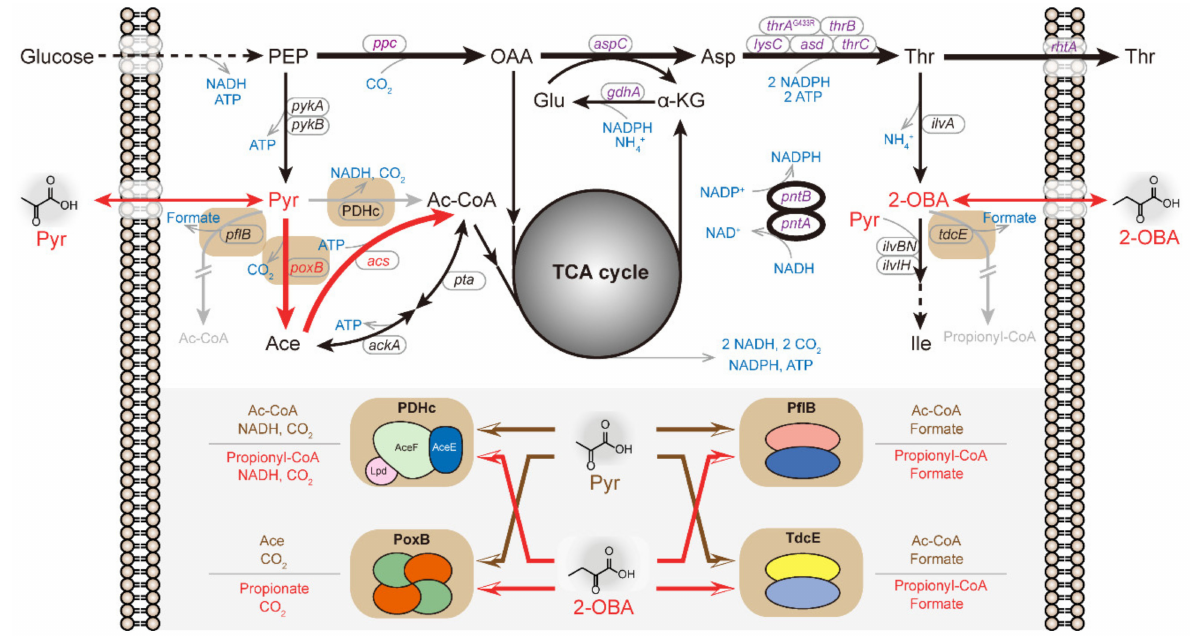
Figure 1. The competition of 2-OBA and Pyr in the L -threonine-overproducing E. coli strain TWF115 and the strategy for metabolic detoxification of 2-OBA. In TWF115, the expression levels of the key enzymes relevant to the L -threonine biosynthetic pathway and pyridine nucleotide transhydrogenase (encoded by pntAB ) are strengthened (bold black lines), and the two genes pflB and tdcE regarding similar catabolic pathways of pyruvate and 2-OBA are deleted (gray lines). In this study, genes poxB and acs , forming acetate bypass, were overexpressed in TWF115 under the temperature-controlled promoter pR-pL (bold red lines). The role of PDHc was replaced with the acetate bypass in the PDHc-deficient strain to convert pyruvate to acetyl-CoA. The L -threonine biosynthesis relied on the cofactor supply (NADPH and ATP) mainly from the TCA (tricarboxylic acid) cycle. The four enzymes PDHc, pyruvate oxidase (PoxB) and pyruvate formate-lyase (PflB and TdcE) involved in the catabolism of 2-OBA and pyruvate are displayed with a light brown background. 2-OBA and pyruvate are potentially exchangeable to participate in these enzyme reactions because of their analog structures. PEP, phosphoenolpyruvate; OAA, oxaloacetate; Asp, aspartate; Pyr, pyruvate; Ace, Acetate; AcCoA, acetyl-CoA; α -KG, α -ketoglutarate; Glu, glutamate; Thr, L -threonine; 2-OBA, 2-oxobutyrate; Ile, L